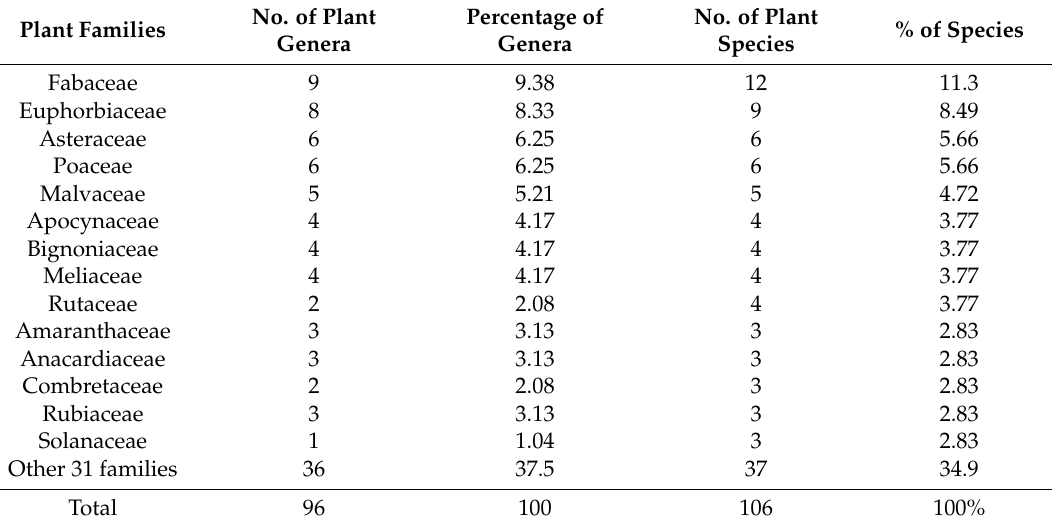
Table 1. Taxonomic diversity of medicinal plants in the Ejisu-Juaben Municipality. No. of Plant Families